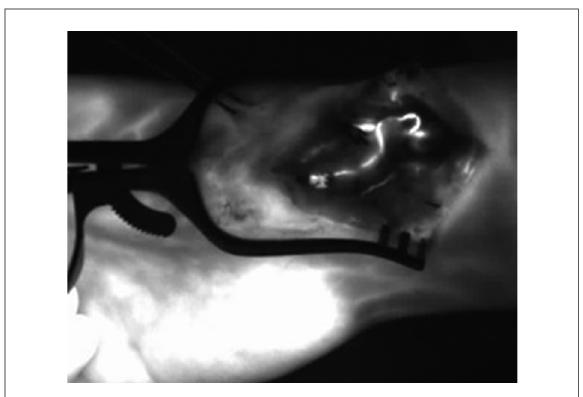
FIGURE 5 After end-to-side anastomosis of the pedicle artery to the radialis artery and ICG dye application. The ICG angiography signal indicates patency of the arterial vascular pedicle of the bone graft; ICG, indocyanine green; NIR,